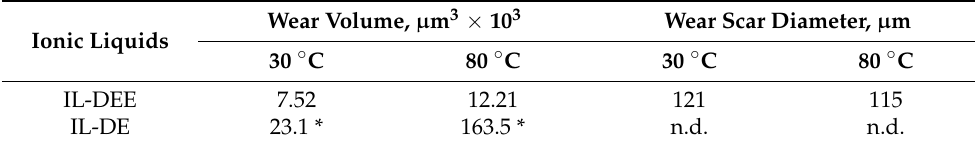
Figure 9. Optical images and cross-section profiles of wear traces on the plate ( a , c ) and wear scars on the ball ( b , d ) observed after the IL-DEE tribo-test at 30 and 80 ◦ C, respectively. P, Pm, and Pe are the cross-section profiles of the wear trace measured in particular locations. The arrows point out the lighter areas in the wear trace. Table 2. Wear volume and wear scar diameter observed in IL-DEE tribo-test using it as a neat